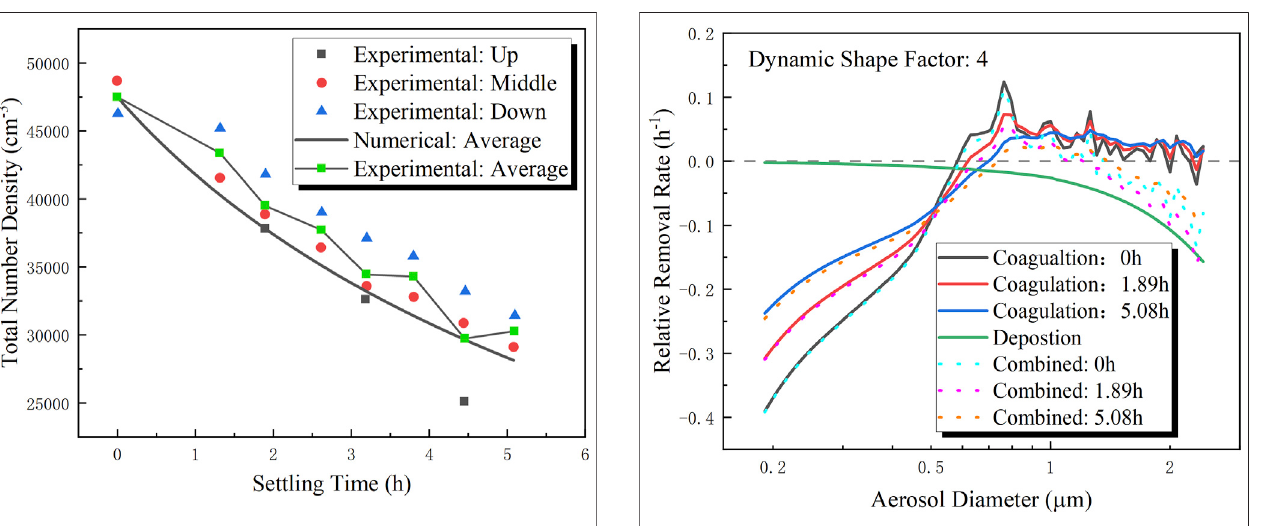
FIGURE 10 | Evolution of the total number density of the aerosol.